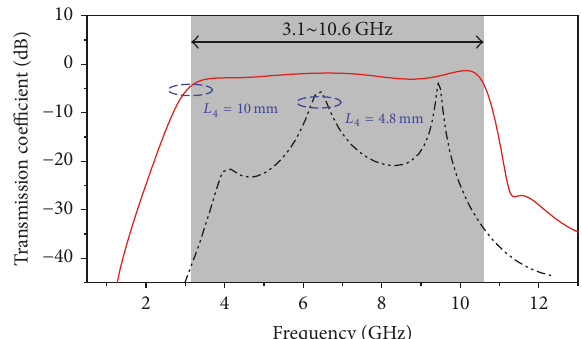
Figure 4: Frequency responses of transmission coefficient of the proposed wideband BPF with different feeding line lengths ( 𝐿 4 ).